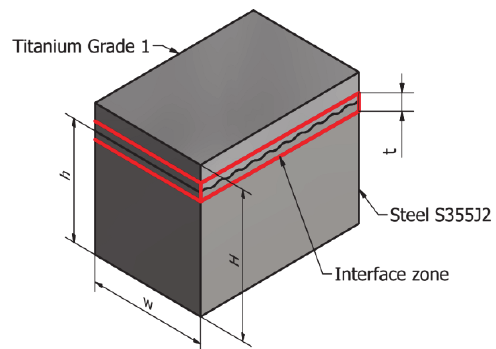
Figure 4: Dimensions of specimen cross